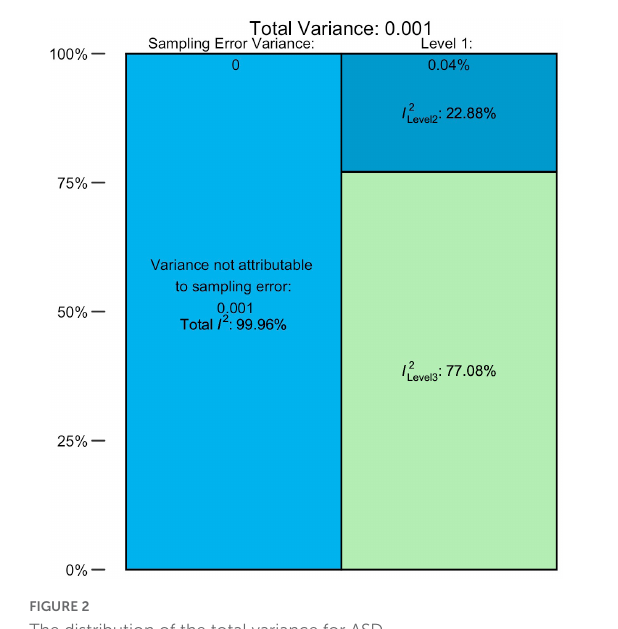
FIGURE2 The distribution of the total variance for ASD.